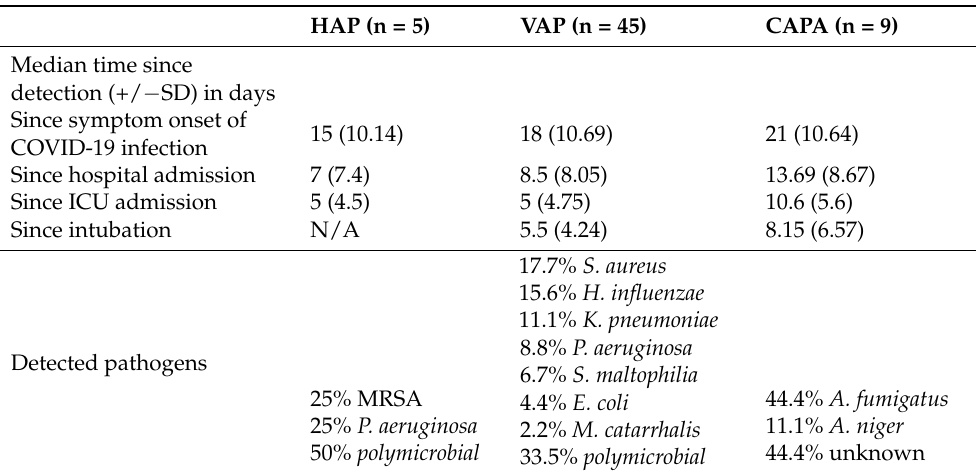
Table 3. Clinical data and pathogens of HAP (hospital-acquired pneumonia), VAP (ventilator-associated pneumonia and CAPA (COVID-19-associated pulmonary aspergillosis).